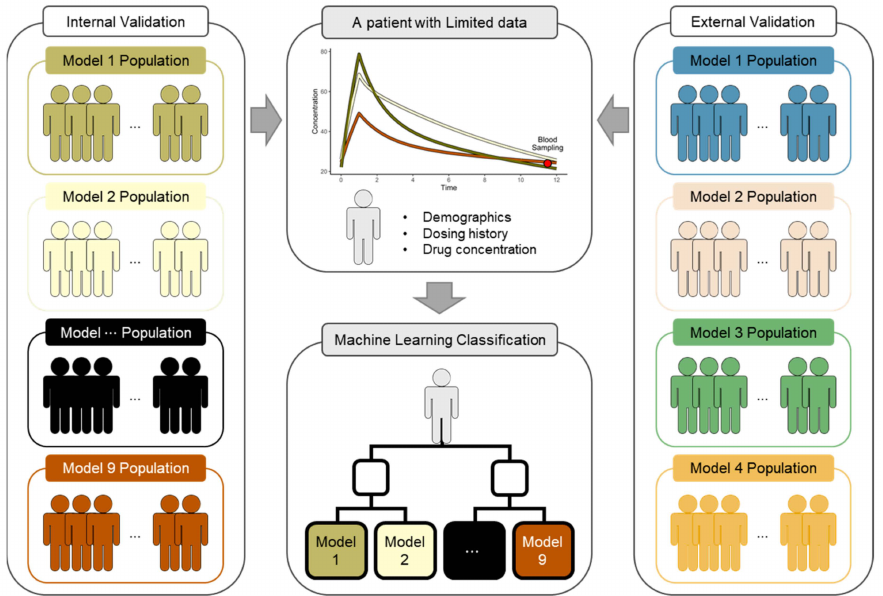
Figure 1. Overview of the study. The results of pharmacokinetic (PK) parameter estimation for TDM can be varied using a PK model as prior information. Therefore, the classifier was created to select a vancomycin PK model more suitable for the patient given the limited data among the nine models. The performance of TDM with the classifier applied was evaluated using the populations generated from nine PK models used as classifiers (internal validation) or from four PK models in another study (external